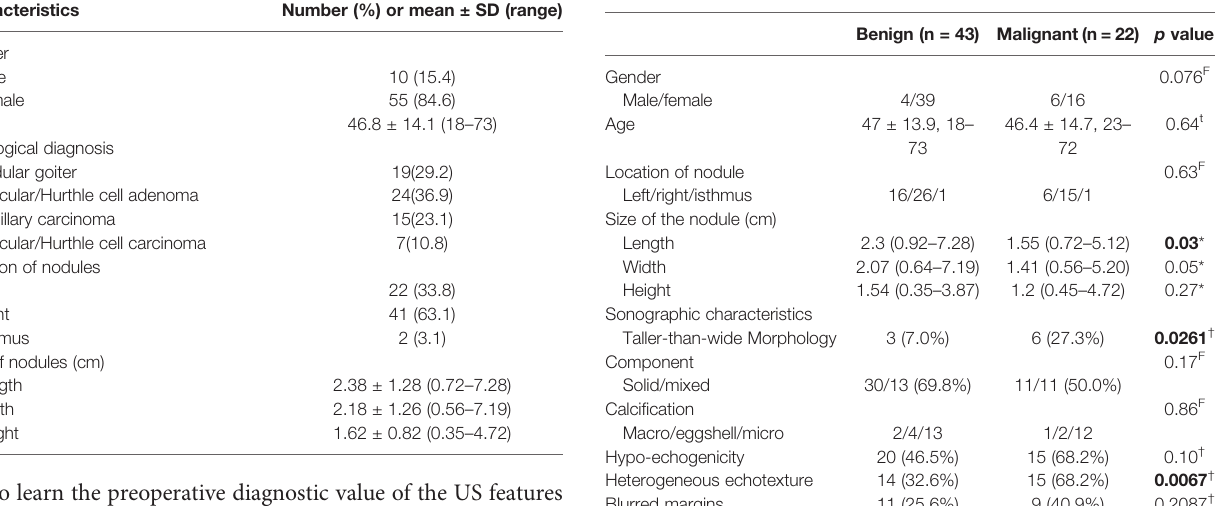
TABLE 2 | Comparison of the demographic characteristics of the participants and sonographic characteristics between thyroid nodules with benign and malignant